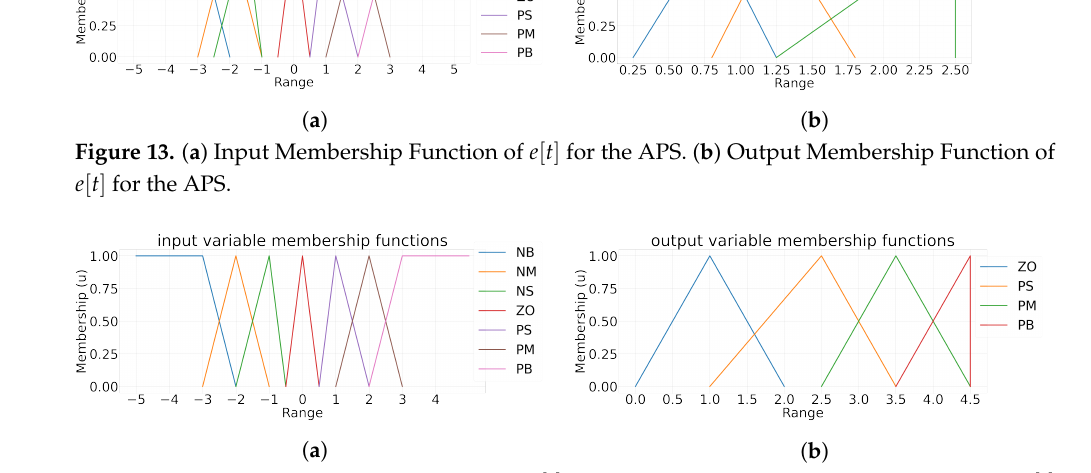
Figure 14. ( a ) Input Membership Function of e [ t ] for BPS. ( b ) Output Membership Function of e [ t ] for